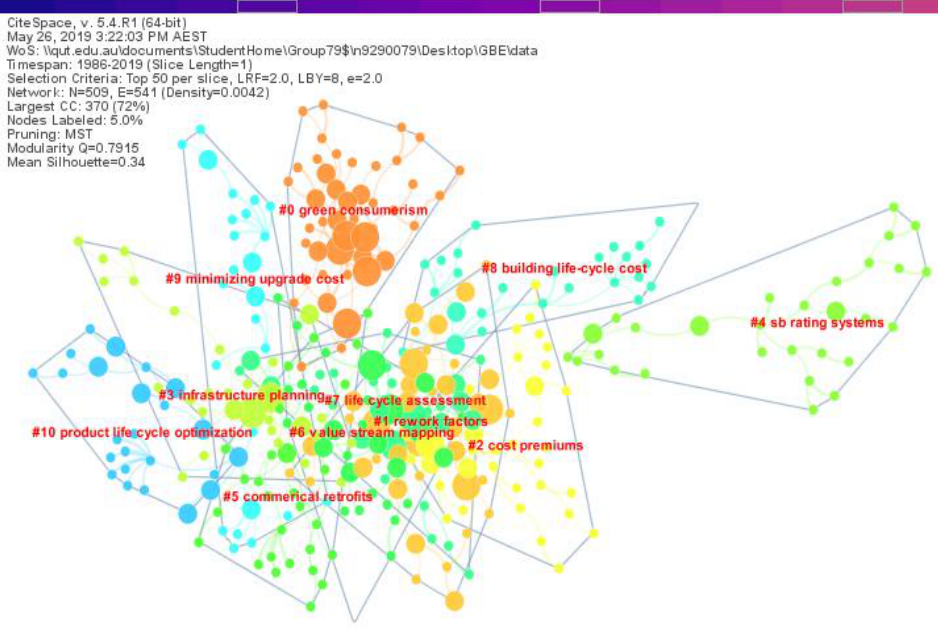
Figure 3. Clusters of knowledge domains.